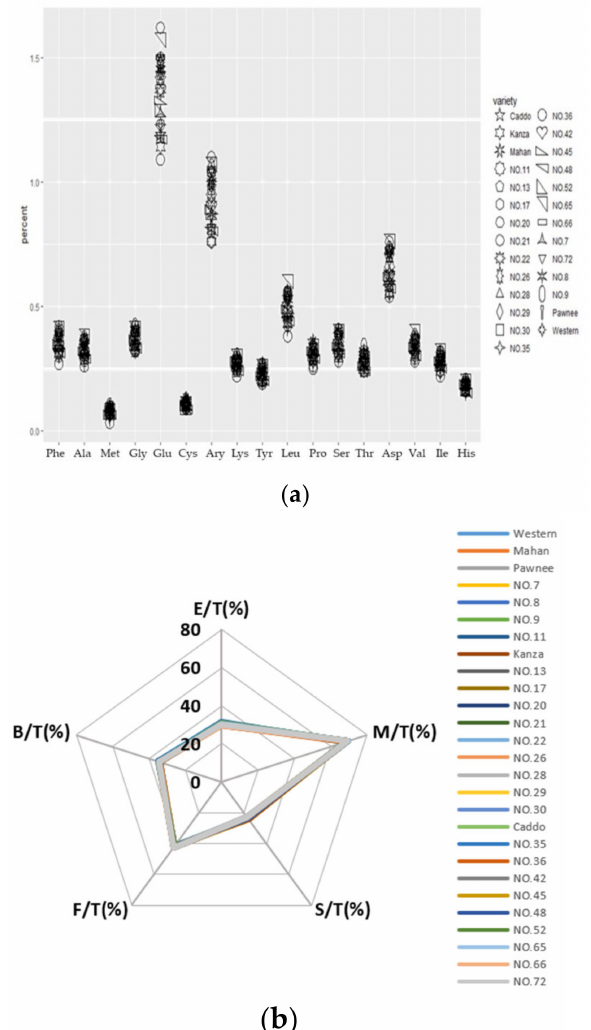
Figure 1. Percentage of each amino acid in total amino acid content ( a ) and different types of amino acids in total amino acid content ( b ) in pecan kernel